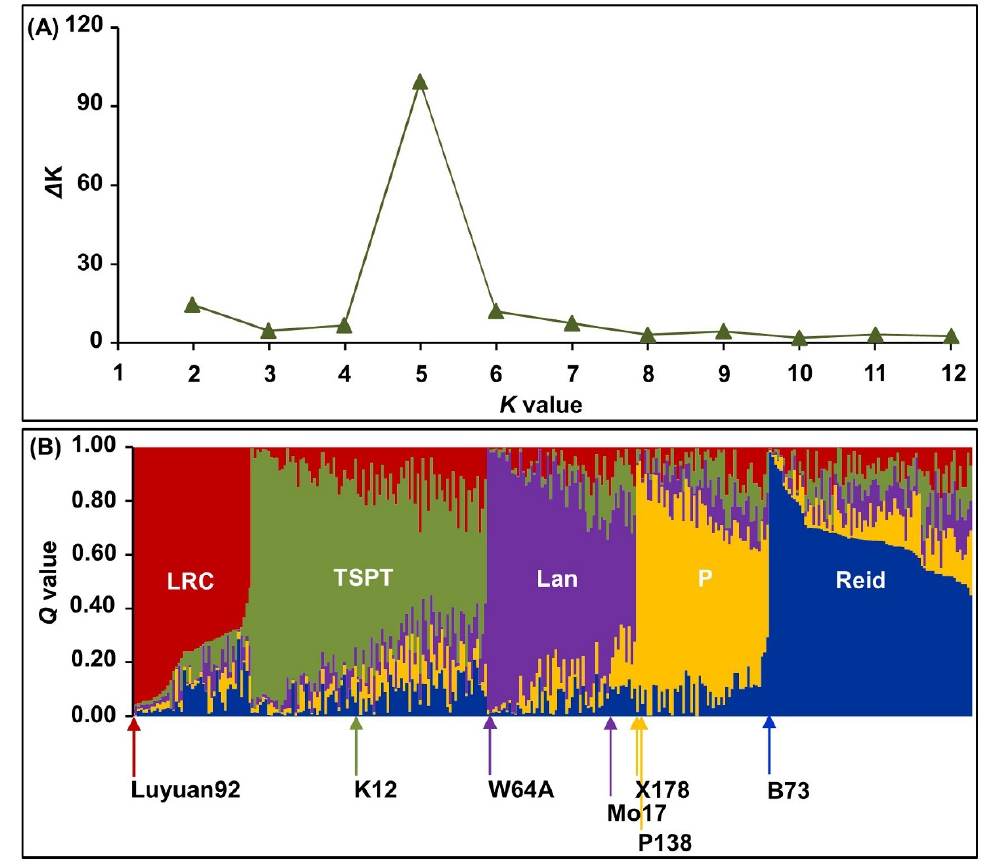
Figure 2. Population structure of 310 maize inbred lines revealed by 186 polymorphic SSR markers. ( A ) Change curve in the log probability data of Δ K value against K (group number) value. ( B ) Population structure of 310 inbred lines based on 186 SSR markers at K = 5. Each inbred line was represented by a vertical line, which indicated the membership coefficient for that individual, and the five groups were the Lüda red cob (LRC), Tang si ping tou (TSPT), Lancaster (Lan), P, and Reid groups, respectively.